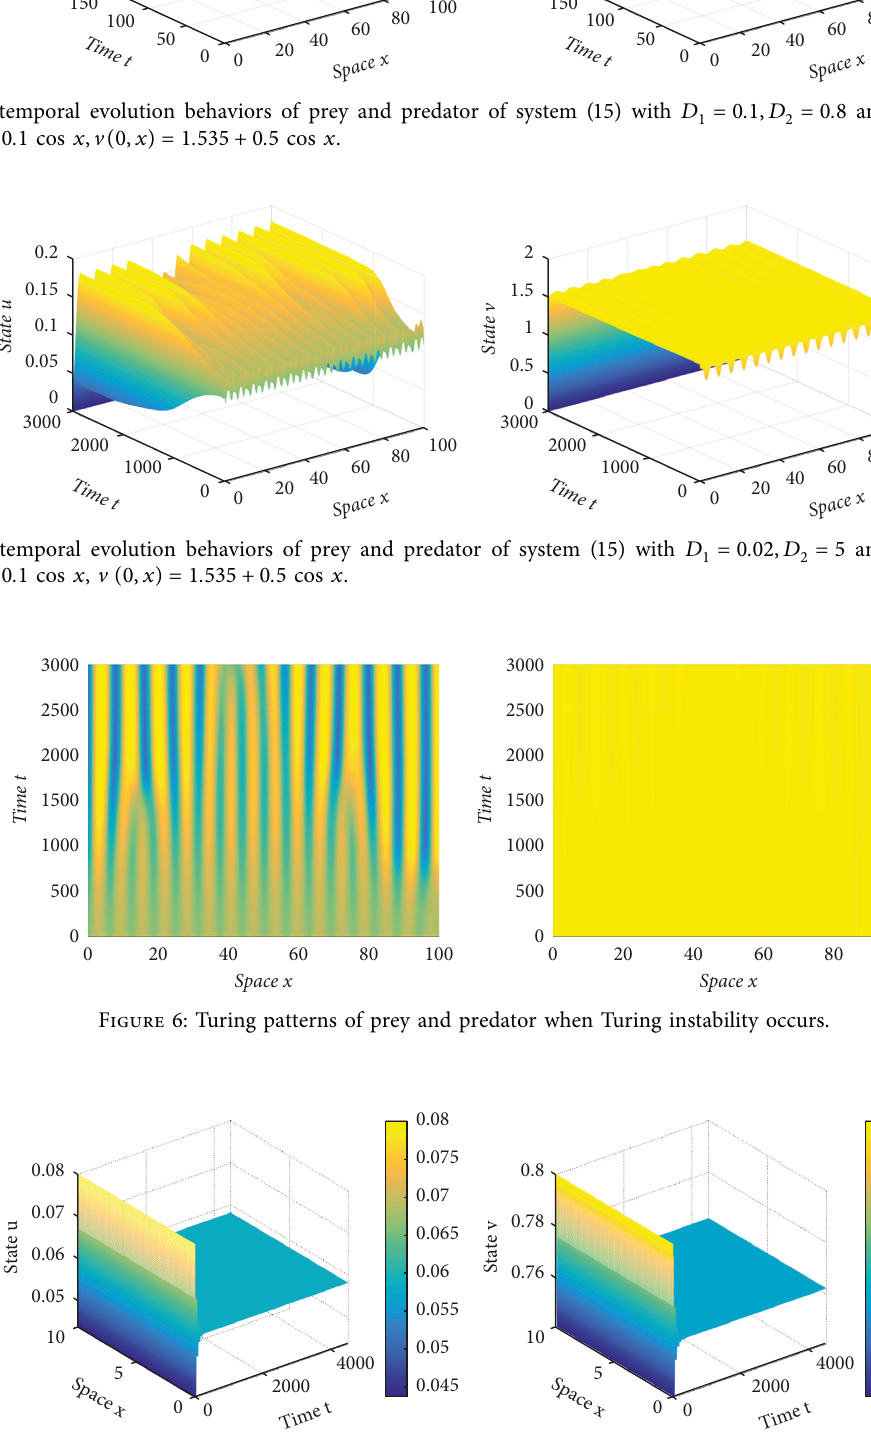
� 0 . 1 , D � 0 . 1, τ � 1 2